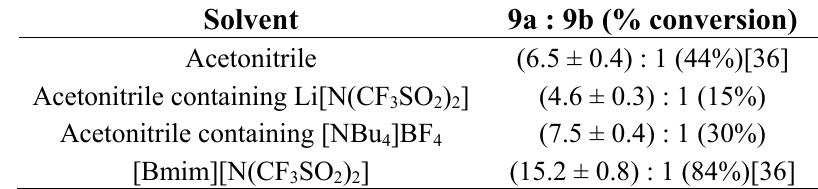
Table 3. Ratios of the isoxazoles 9a and 9b produced in the reaction outlined in Scheme 4 in the solvent systems specified and extents of conversion. Uncertainties quoted are standard